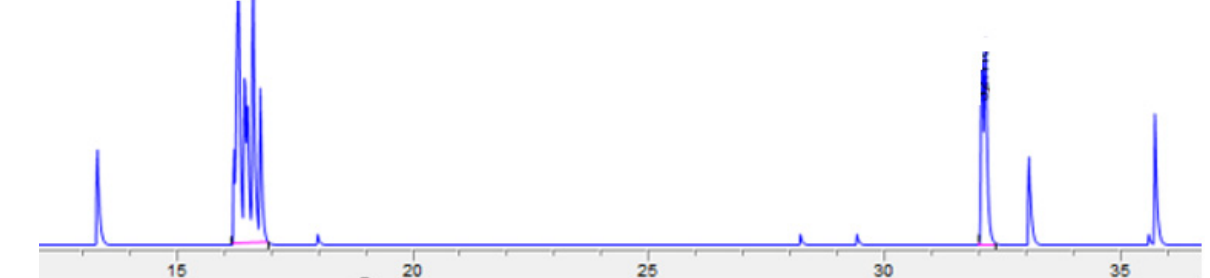
Figure 3. A chromatogram showing the production of radiolabeled free androstenone (32 min) from androstenone sulfate (16 min) following an incubation assessing steroid uptake and conversion by adipocytes.